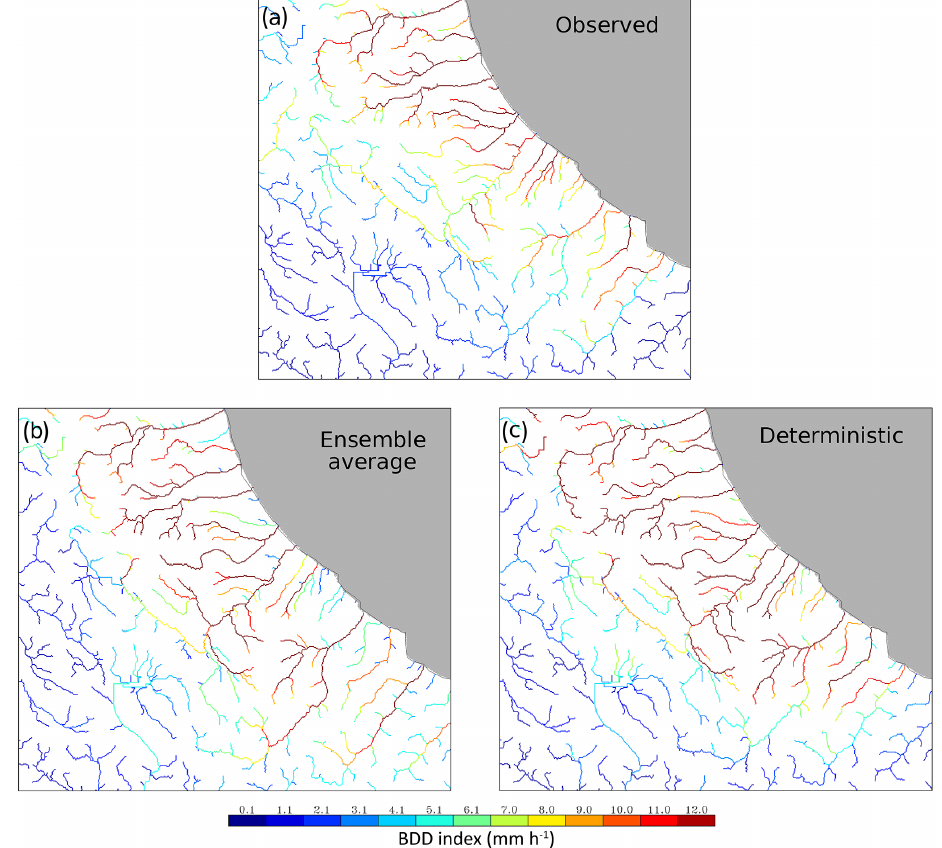
Figure 11. The 24h BDD index computed by CHyM using (a) the observed accumulated precipitation, (b) the mean precipitation produced by the WRF ensemble and (c) the precipitation produced by the deterministic WRF at 1km (HR).